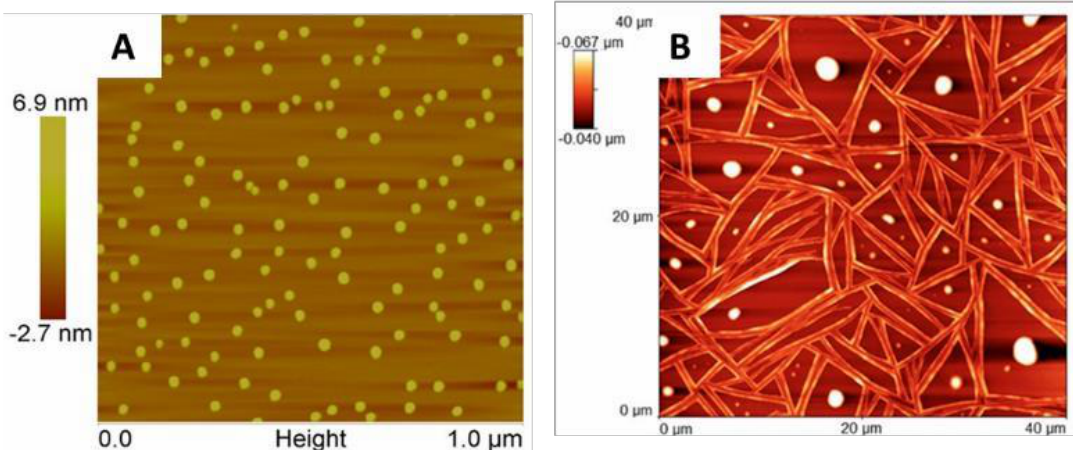
Figure 9. Atomic force microscopy (AFM) of crystal 6 during ( A ) nucleation and ( B ) growth in DMF at 130 °C.